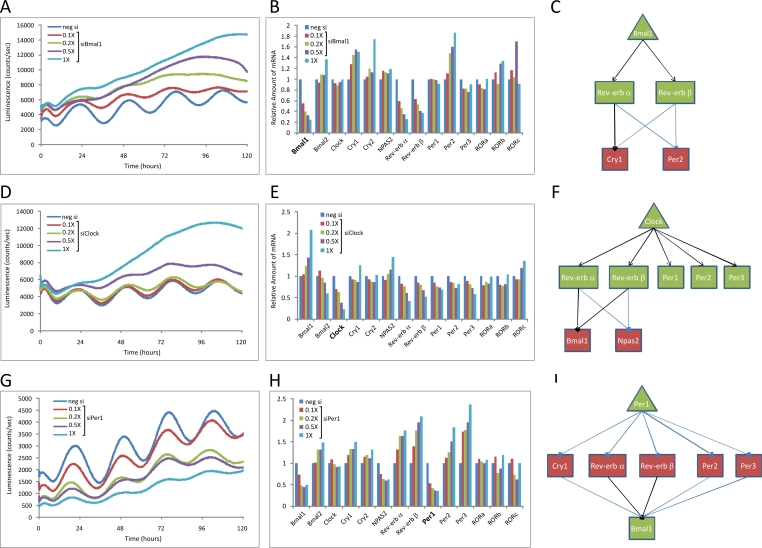
GDNA Following Genetic Perturbation of Bmal1, Clock, and Per1
(A, D, and G) Oscillations in Bmal1-luciferase were measured from cells transfected with increasing amounts of siRNAs targeting Bmal1, Clock, or Per1.(B, E, and H) RNA was isolated from replicate samples collected at time 0 (before synchronization) and expression of clock genes was determined by quantitative real time PCR.(C, F, and I) GDNAs were generated for siBmal1 (C), siClock (F), and siPer1(I) using expression data from each knockdown condition. Edges between genes were determined using nonparametric Pearson correlation (p-value < 0.10) and biochemical constraints, and gene expression changes are denoted as increases (red) and decreases (green). The gene being depleted is located at the top of network, with first order responses below as restricted by biochemistry, i.e. genes that decrease when Clock and Bmal1 activators are decreased (C and F) and genes that are increased with the Per1 repressor is decreased (I). Second-order responses are defined as those with correlated edges with the first-order responders. Black lines indicated published edges, and blue lines denote unpublished relationships.